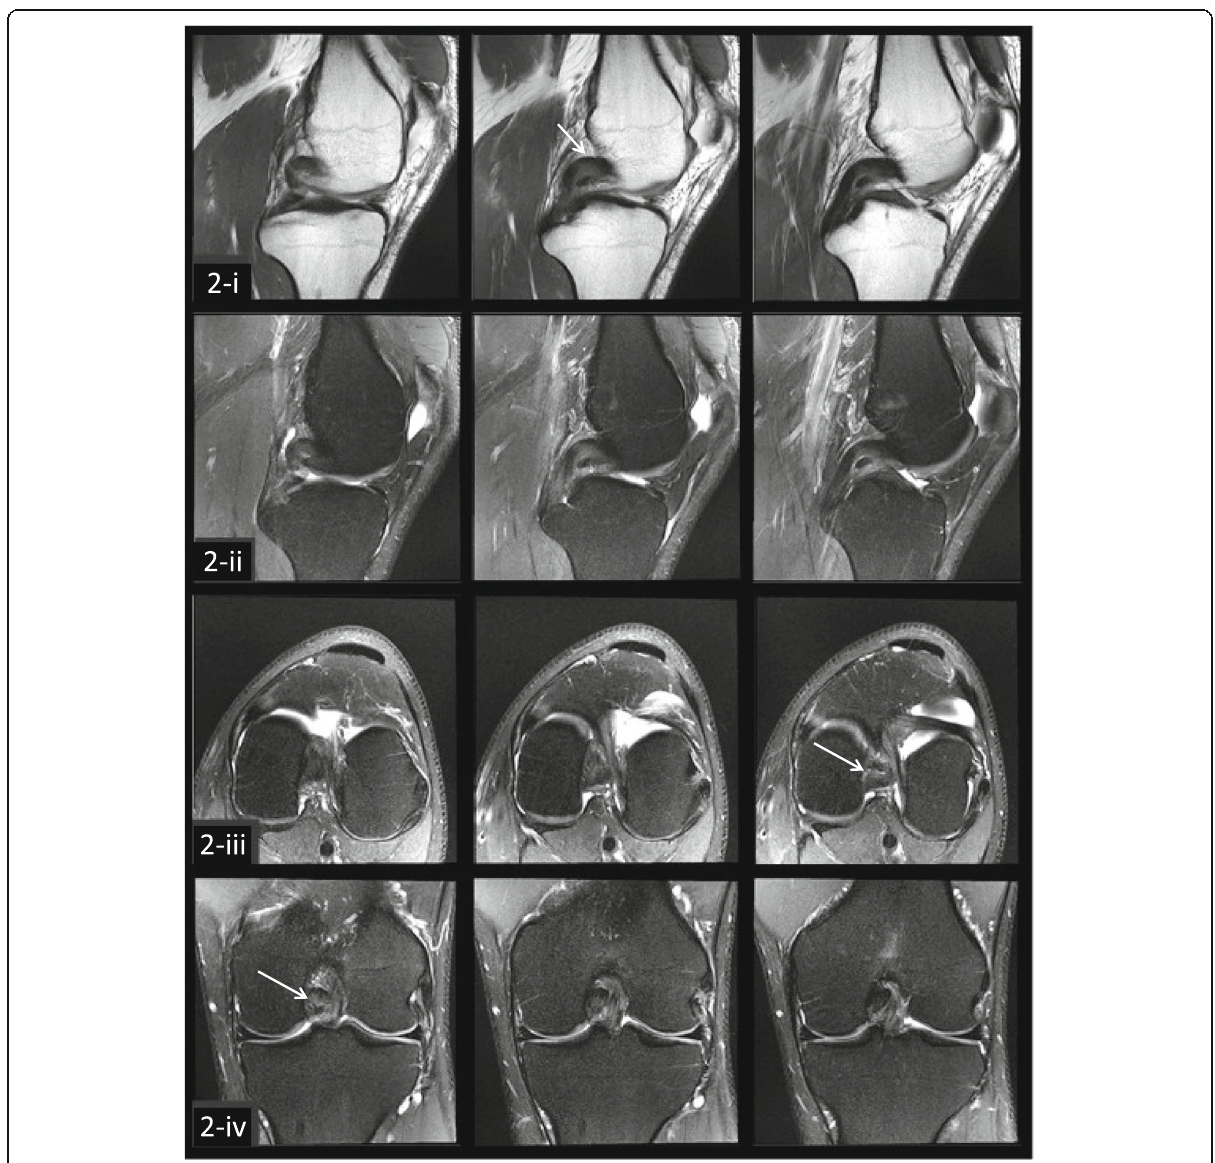
Fig. 3 Example images of subject 2 showing three consecutive slices of the PCL from four MR imaging sequences, including i) PD TSE sagittal, ii) PD FS TSE sagittal, iii) PD FS TSE axial, iv) PD FS TSE coronal. This subject was a 28-year old male with a chronic PCL injury from a fall. On original imaging evaluation the radiologist noted minimal focal increased signal within the mid PCL substance likely indicative of mild scarring